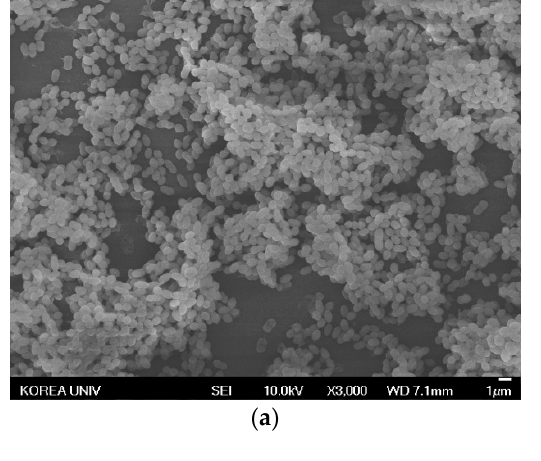
( d ) Figure 10. SEM images of MRAB treated with AgNPs. ( a ) Negative control magnified 3000×. ( b ) Negative control magni- fied 20,000×. ( c ) AgNP-treated MRAB magnified 3000×. ( d ) AgNP-treated MRAB magnified 20,000×. 4. Conclusions